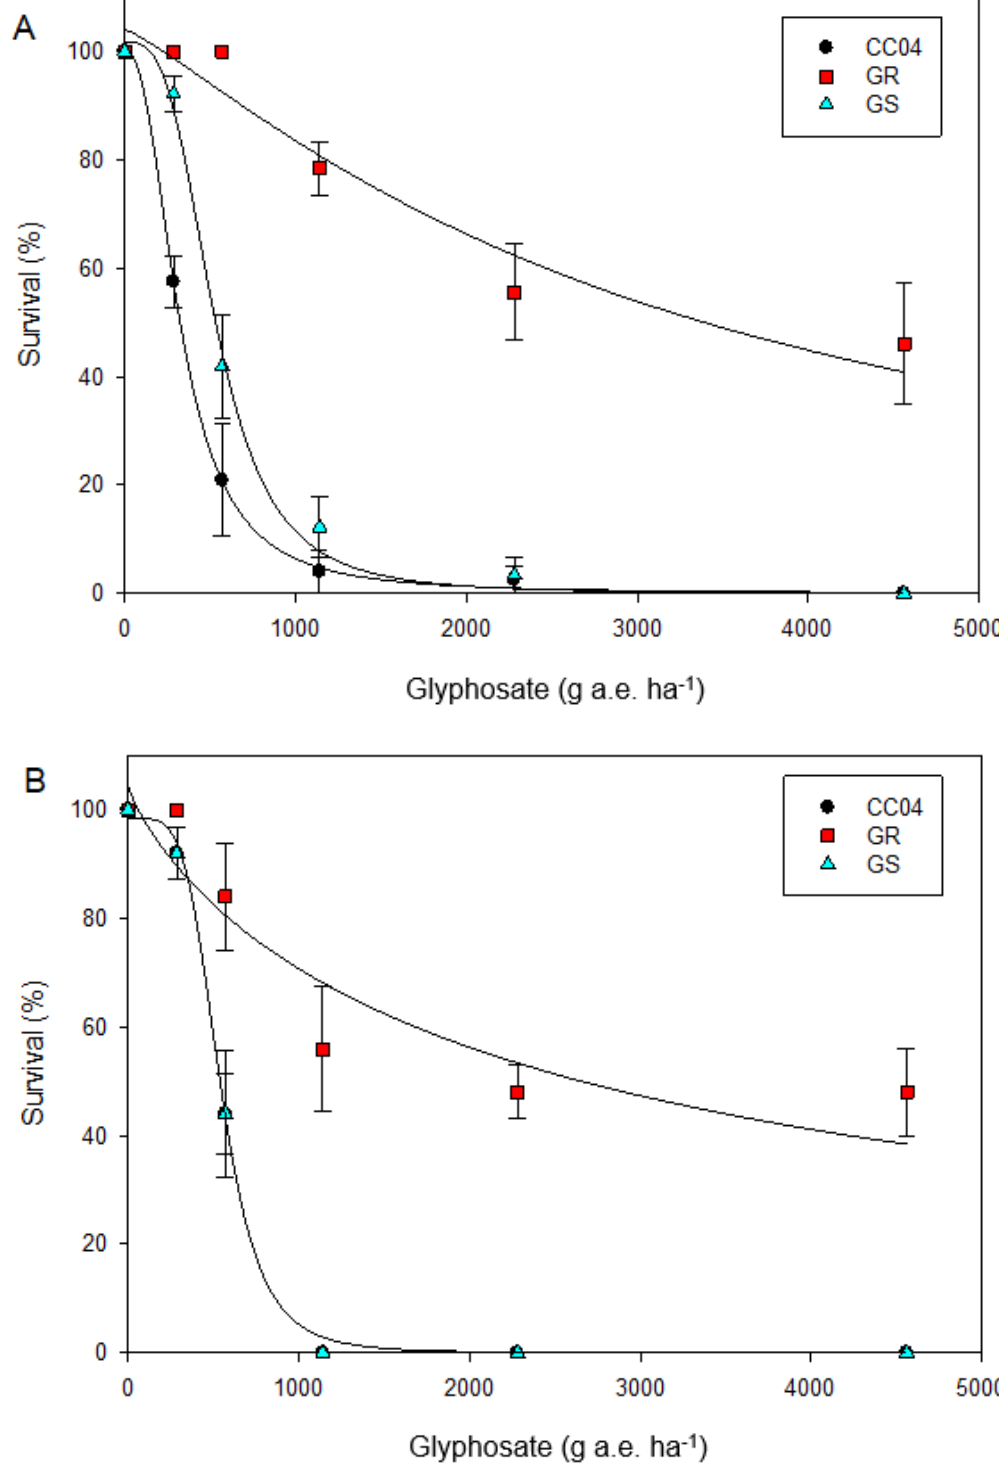
Figure 1. Survival response of three Lolium rigidum populations (CC04, GR, and GS) to six rates of glyphosate in ( A ) 2019 and ( B ) 2020. Data are presented as the average percentage of plants that survived and error bars represent the standard error of the mean.